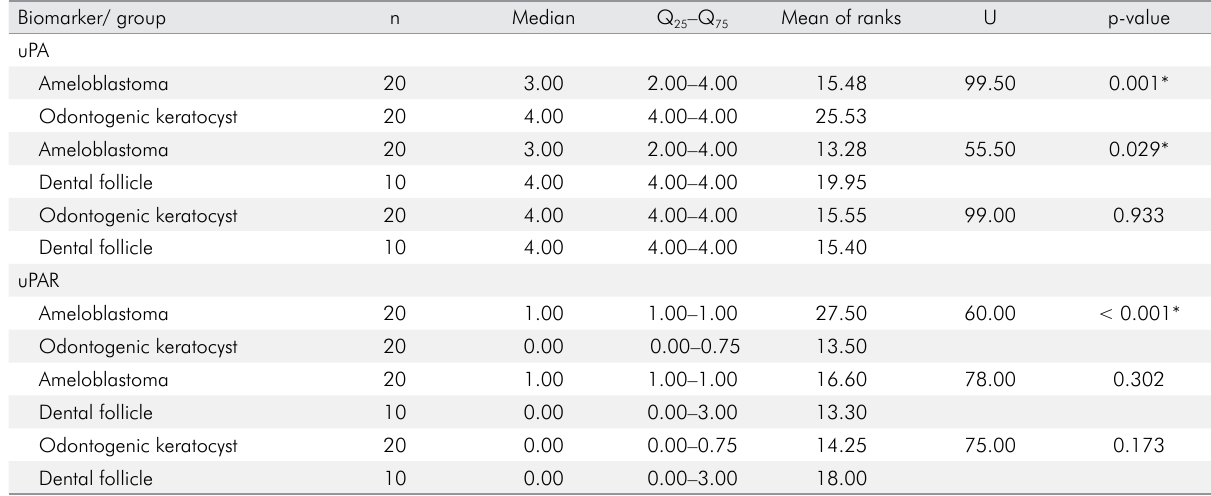
Table 3. Parameters used for the calculation of the Mann-Whitney ( U ) test for the evaluation of the epithelial scores of immunoexpression of uPA and uPAR in ameloblastomas, odontogenic keratocysts and dental follicles. Biomarker/ group